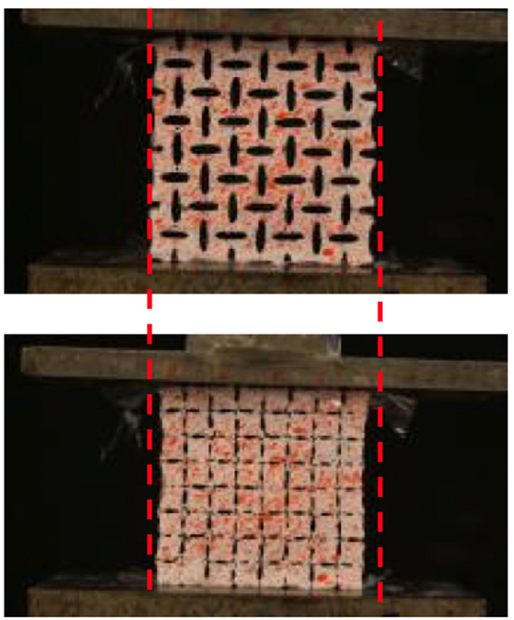
Figure 11 . Cellular cementitious composite with auxetic behaviour. (top) unloaded; (bottom) under loading. Red dashed lines indicate that the specimen contracts laterally under vertical compressive